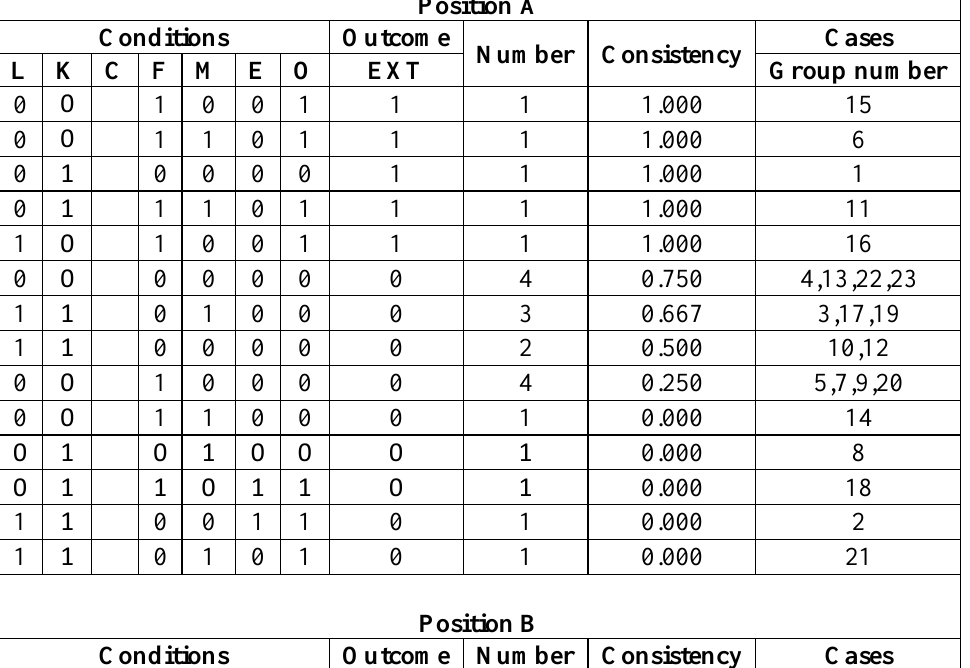
Table A3.6. Truth table of csQCA for the analysis of sufficiency for the group success at each position. L=Leader, K=Knowledge generator, C=Connector, F=Follower, M=Moralist, E=Enforcer,